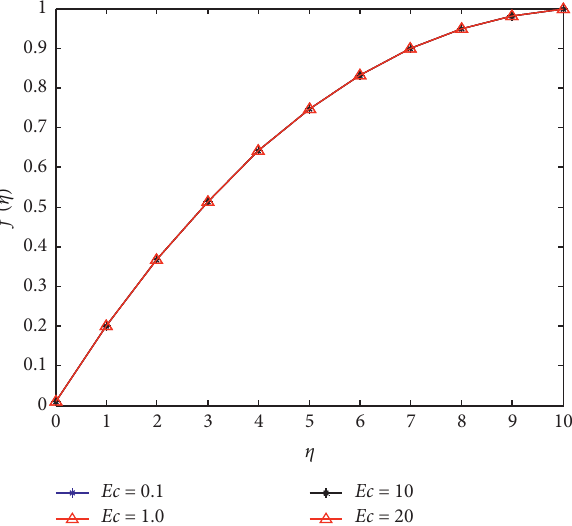
Figure 6: Velocity graph for altered values of Ec when Pr � 0 . 72,